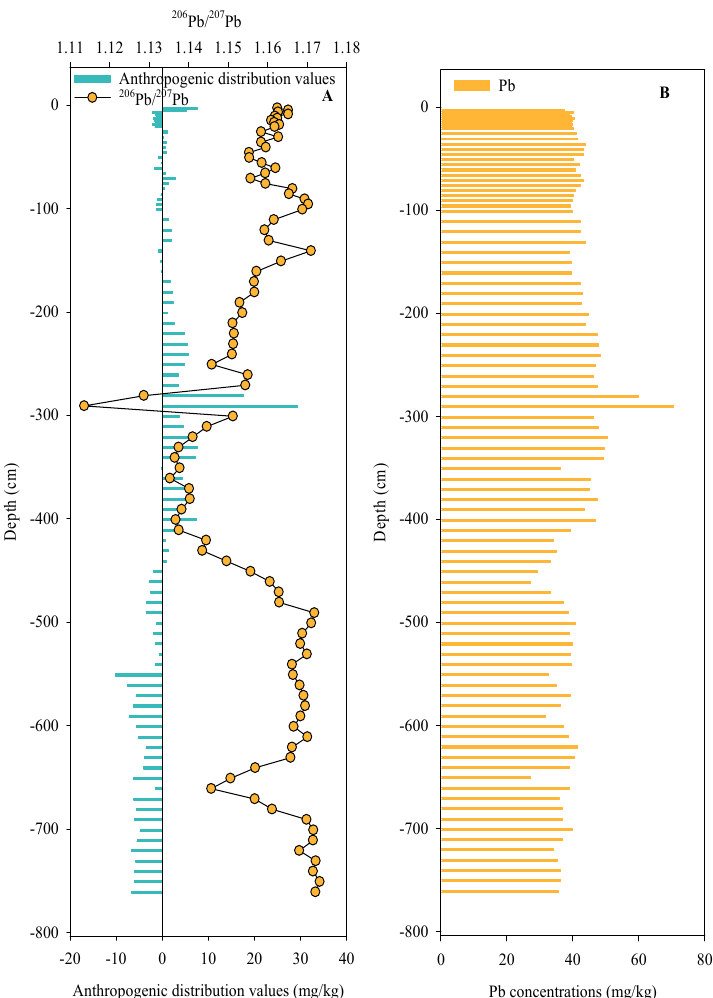
Figure 3. Pb concentrations, distribution characteristics of anthropogenic distribution values, and 206 Pb / 207 Pb in sediment profile (( A ) presents the distribution values of R d and 206 Pb/ 207 Pb in sediment profile; ( B ) presents the distribution of Pb concentrations in sediment profile).